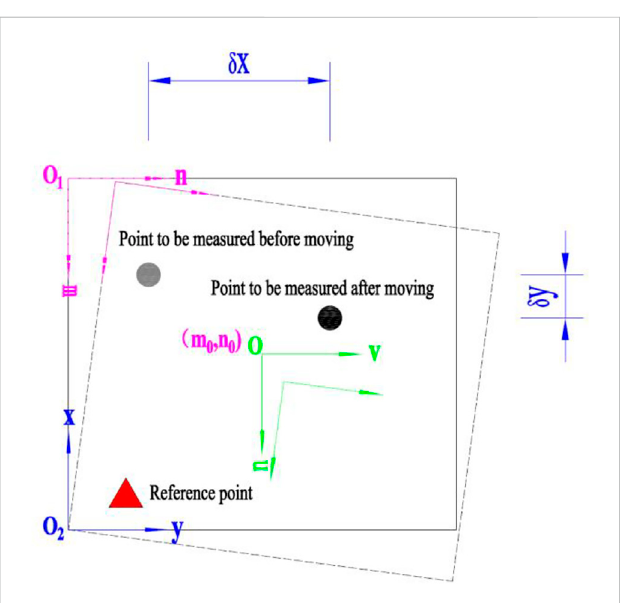
FIGURE 3 Comparison of imaging effects before and after slight changes in camera